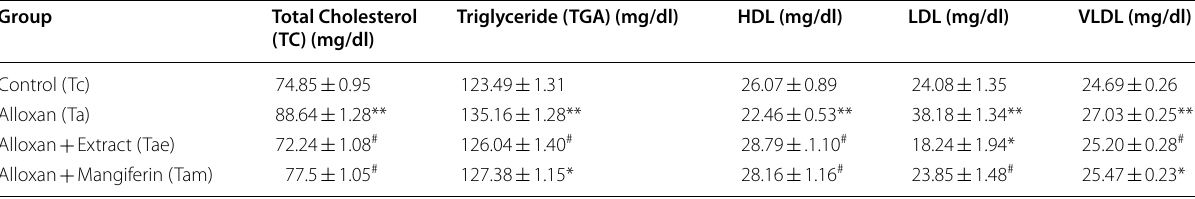
Values are mean SEM ( n 6); *Significant at 5% level, **Significant at 1% level and # Not significant ± = The fluctuations of serum total cholesterol, triglyceride, HDL, LDL, and VLDL levels in different groups are stated in Table 4. Ta group has higher serum cholesterol, triglyceride, HDL, LDL, and VLDL levels, and they are significantly different ( p < 0.01) than the Tc group. Tae group had a significant difference ( p < 0.05) in LDL levels compared with the control group. Tam group had a significant difference ( p < 0.05) in triglyceride and VLDL levels when compared with the control